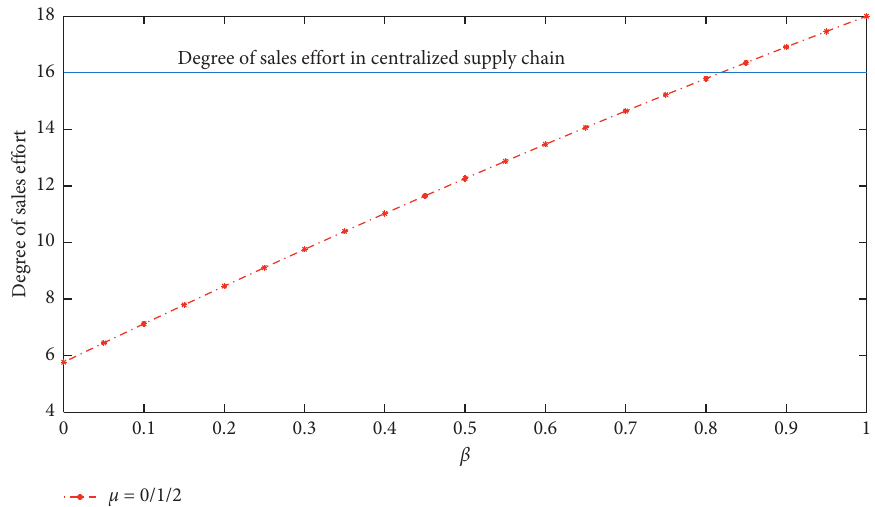
Figure 2: The effect of the cognitive biases on optimal sales effort.